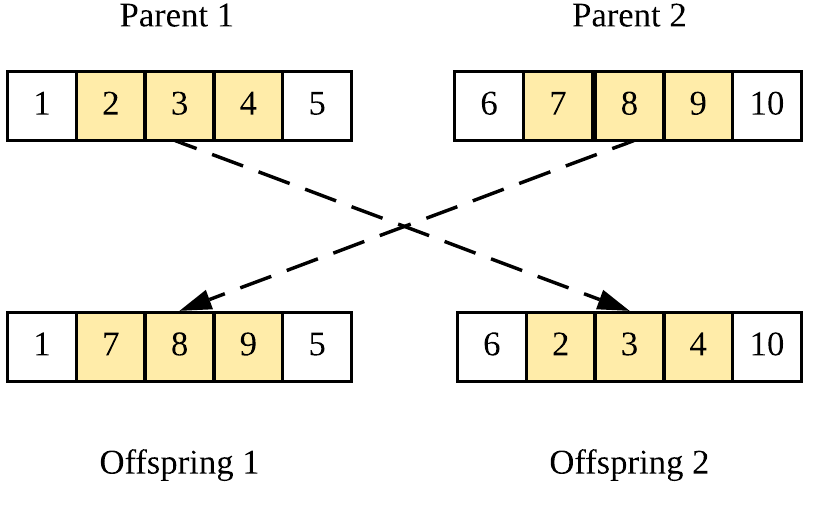
Figure 4. Two-point crossover